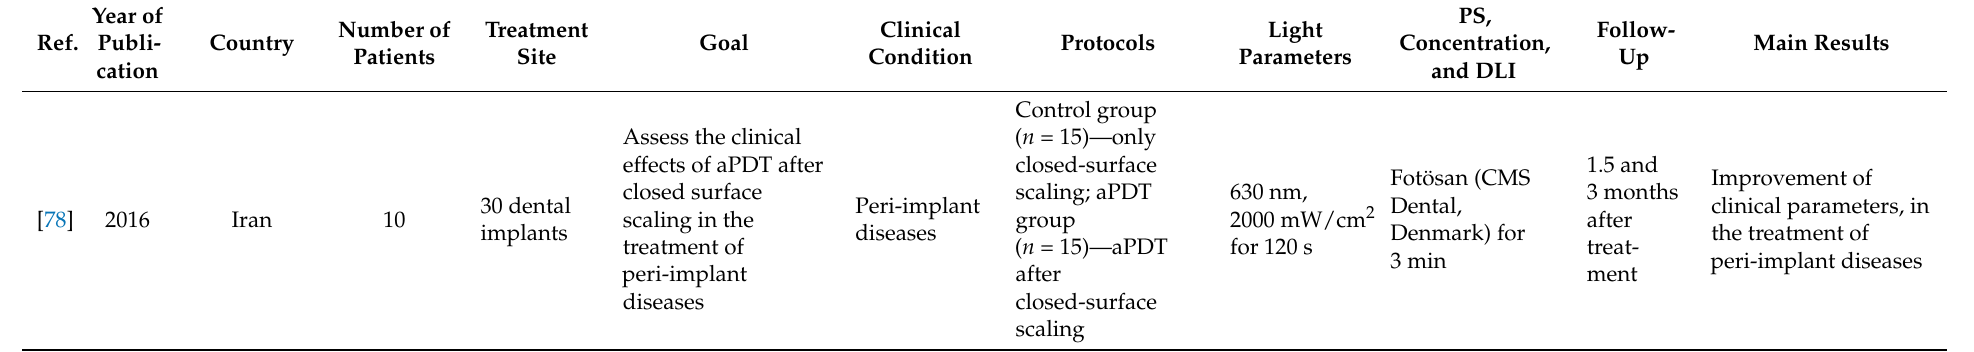
Table 4. Randomized clinical trials that evaluated aPDT for the treatment of dental infections.